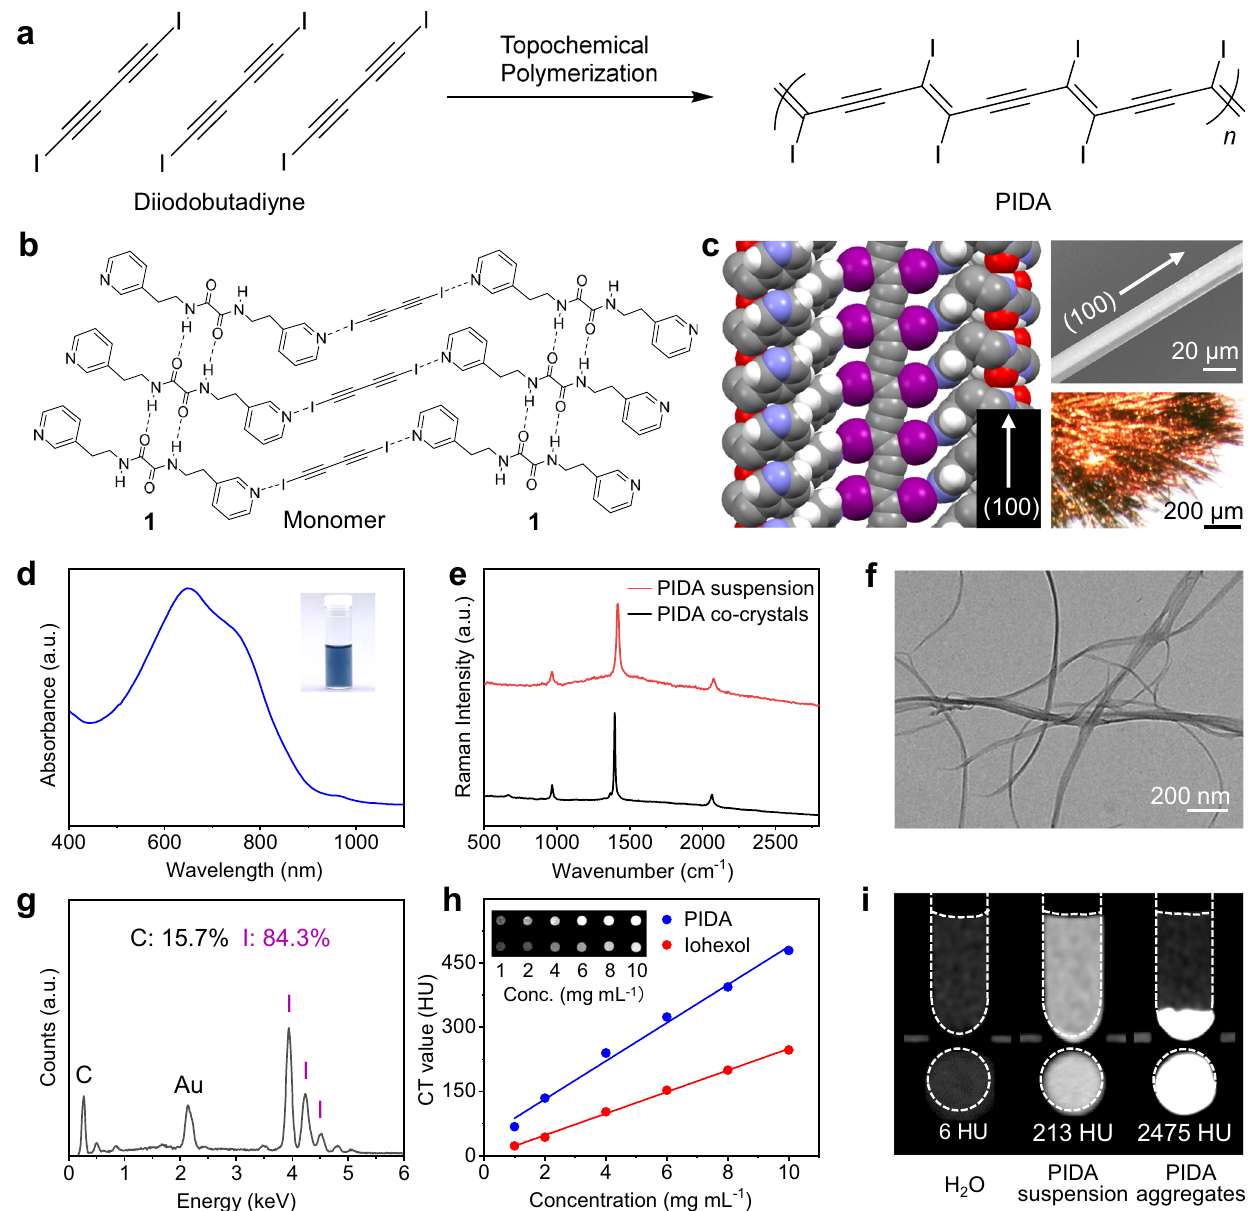
Fig. 1 Preparation and characterization of PIDA. a Synthesis of PIDA by topochemical polymerization. b Supramolecular scaffold formed between scaffold 1 and monomer diiodobutadiyne. c Single-crystal structure of PIDA (cid:129) 1 co-crystals determined by X-ray diffraction (left), and SEM (top right) and optical (bottom right) images of PIDA (cid:129) 1 co-crystals, with the long dimension corresponding to the (100) axis. Each experiment was repeated 3 times independently with similar results. d UV-vis absorption spectrum of the PIDA suspension. Inset: Picture of the PIDA suspension. e Raman spectra of PIDA (cid:129) 1 co-crystals and the prepared PIDA suspension. f TEM image of dispersed PIDA nano fi bers in the PIDA suspension. The experiment was repeated 3 times independently with similar results. g Elemental analysis of PIDA by EDX. h CT values of PIDA and iohexol as a function of sample concentrations. Inset: CT images of PIDA suspension and iohexol at corresponding concentrations. i CT images of pure water, PIDA suspension (5 mg mL − 1 ), and PIDA aggregates. Top row: side view; Bottom row: Top view. Source data are provided as a Source Data fi